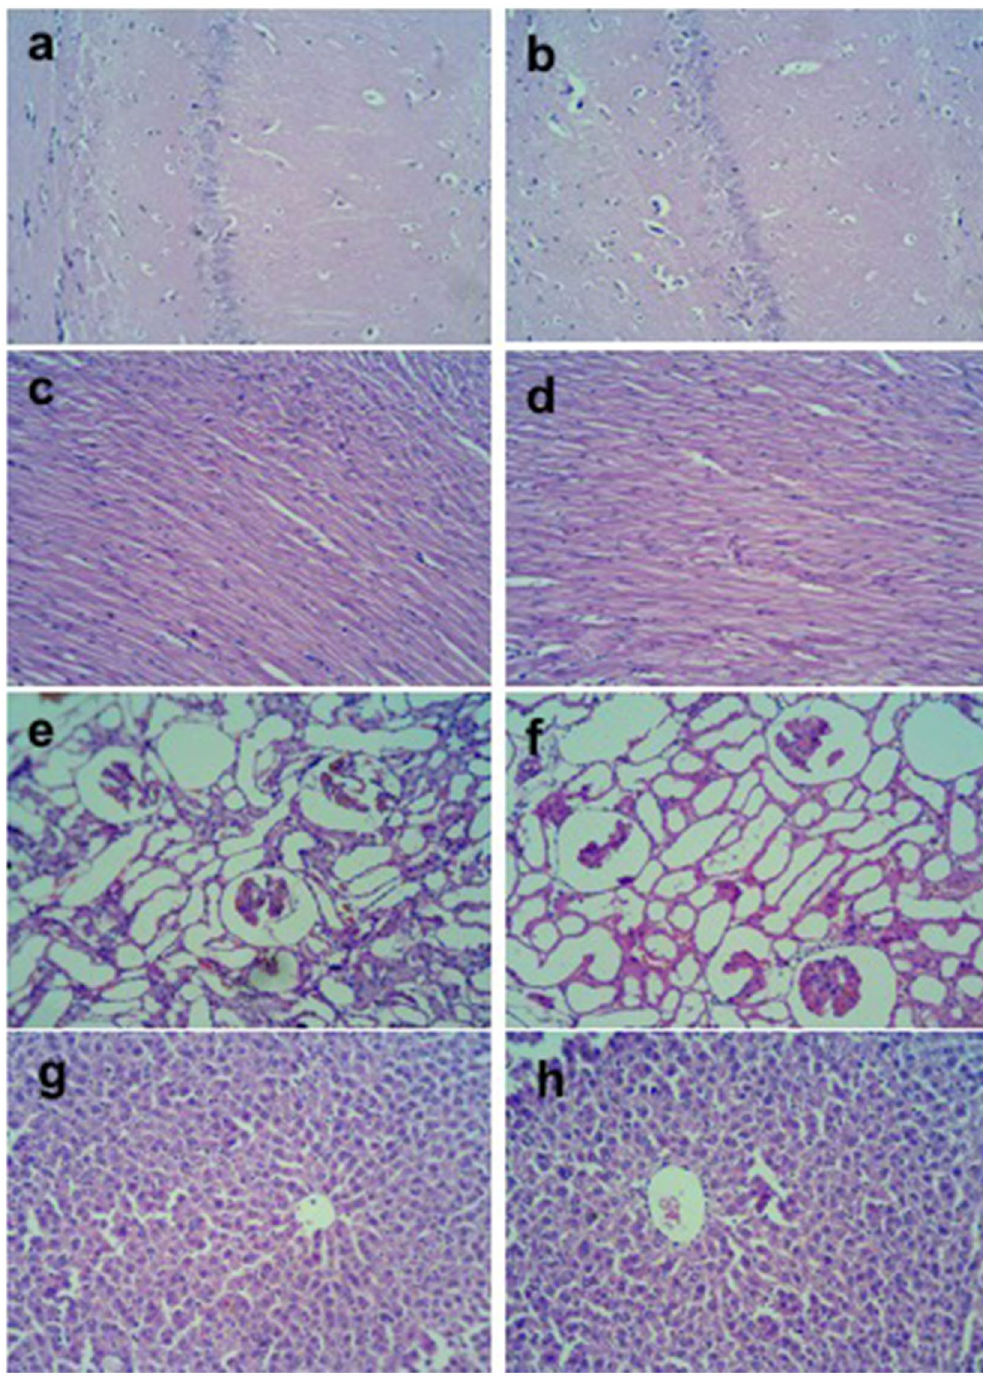
Figure 8. Histological sections of brain (a-Control, b-eNGS), (c-Control, d-eNGS) heart, (e-Control, f-eNGS) kidney, and (g-Control, h-eNGS) liver from each group. Photomicrographs of each tissue of normal control and eNGS rats were taken at